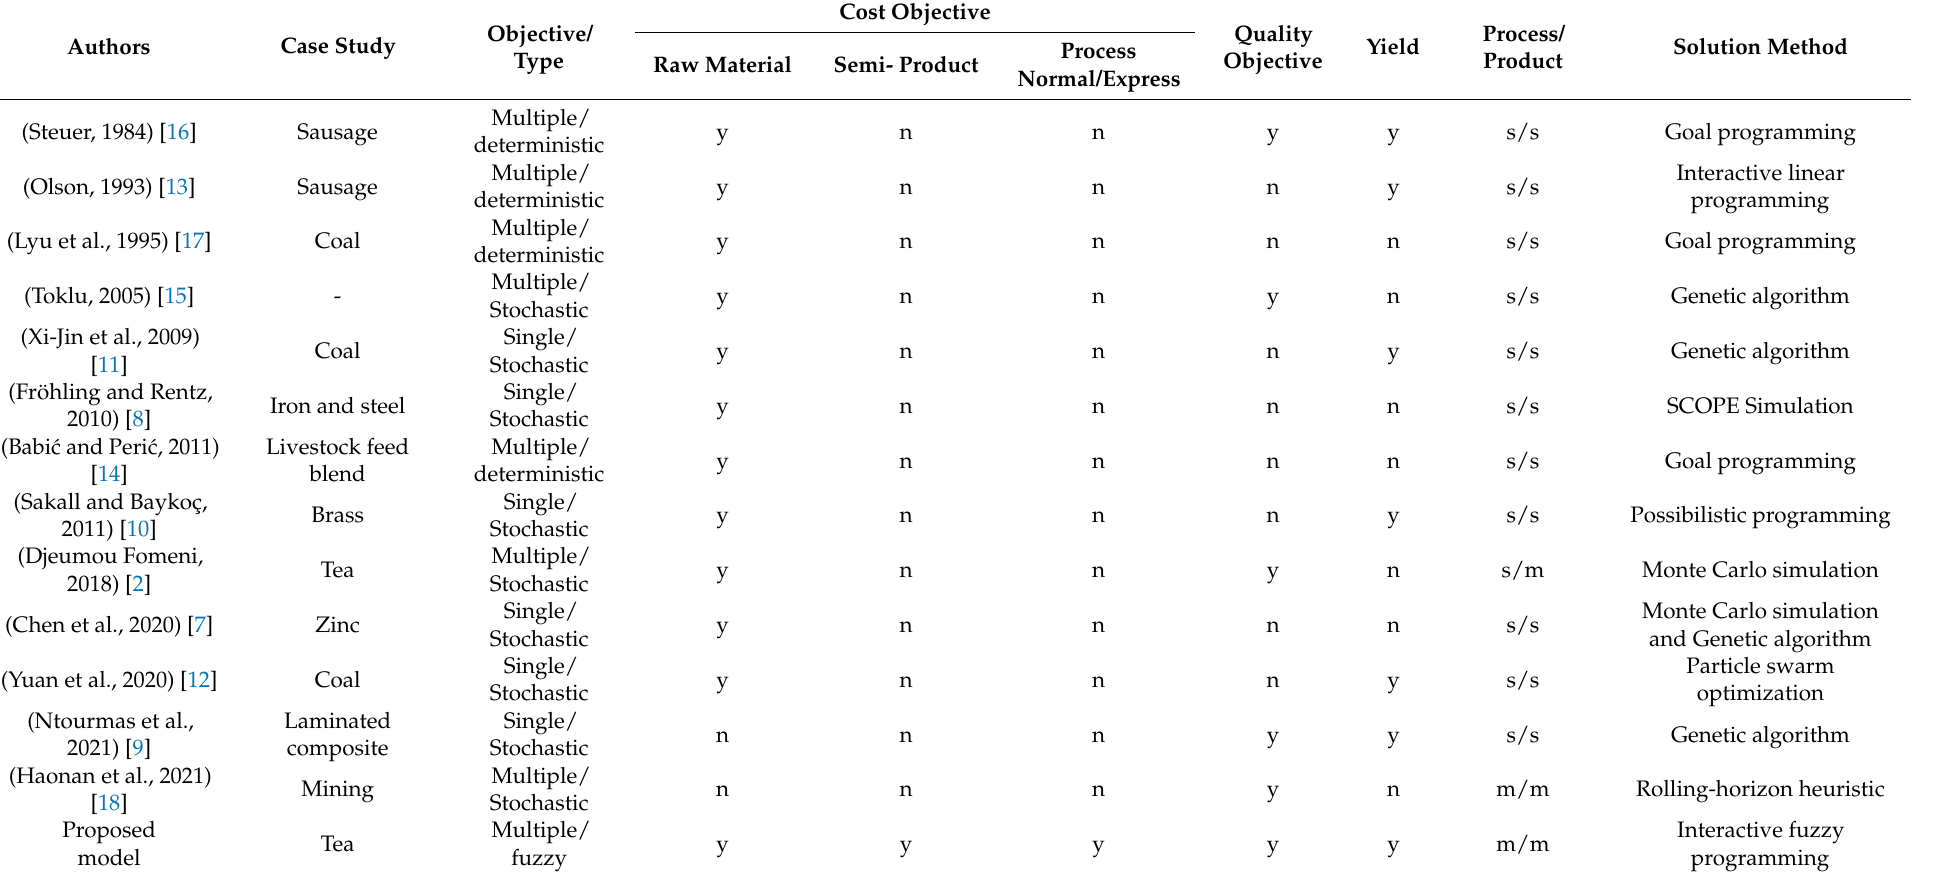
Table 1. Review of the related studies of the blending